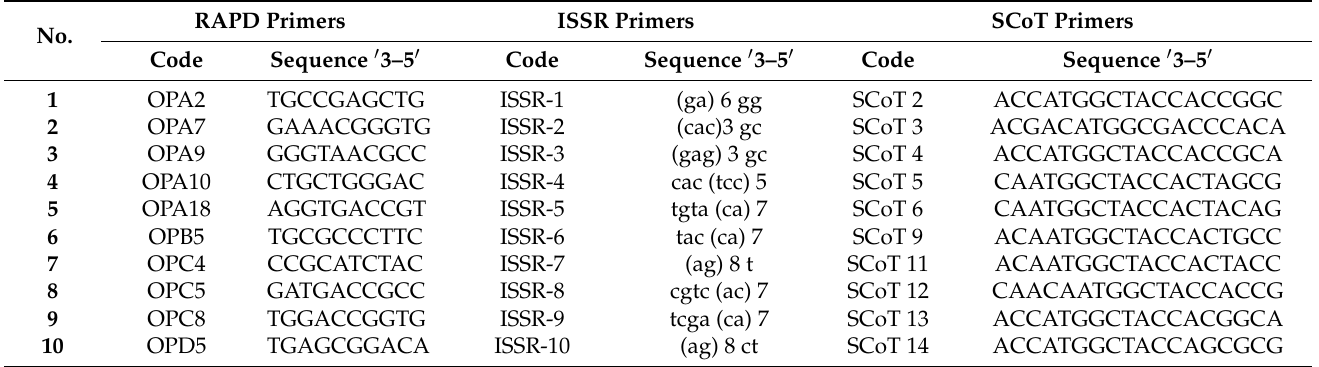
Table 2. Codes and sequences of RAPD, ISSR and SCoT